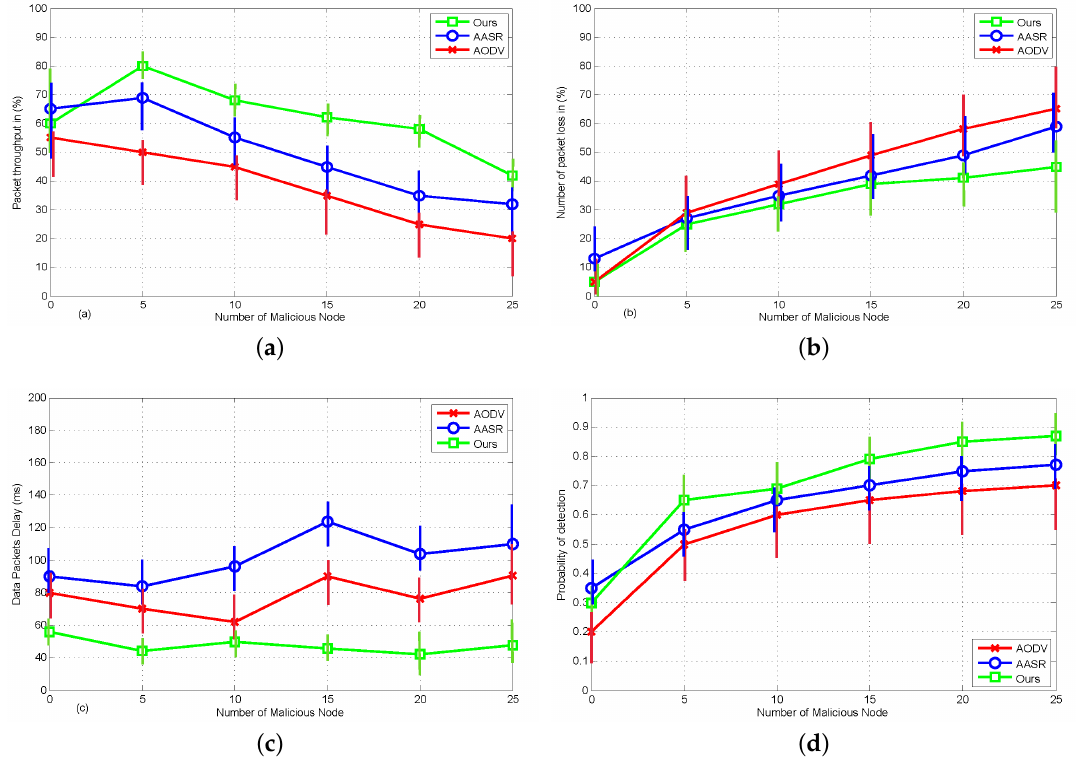
Figure 9. Performance comparison under different attack pattern: ( a ) Packet throughput. ( b ) Packet loss ratio. ( c ) End-to-end delay. ( d ) Probability of detection in between benevolent and malicious